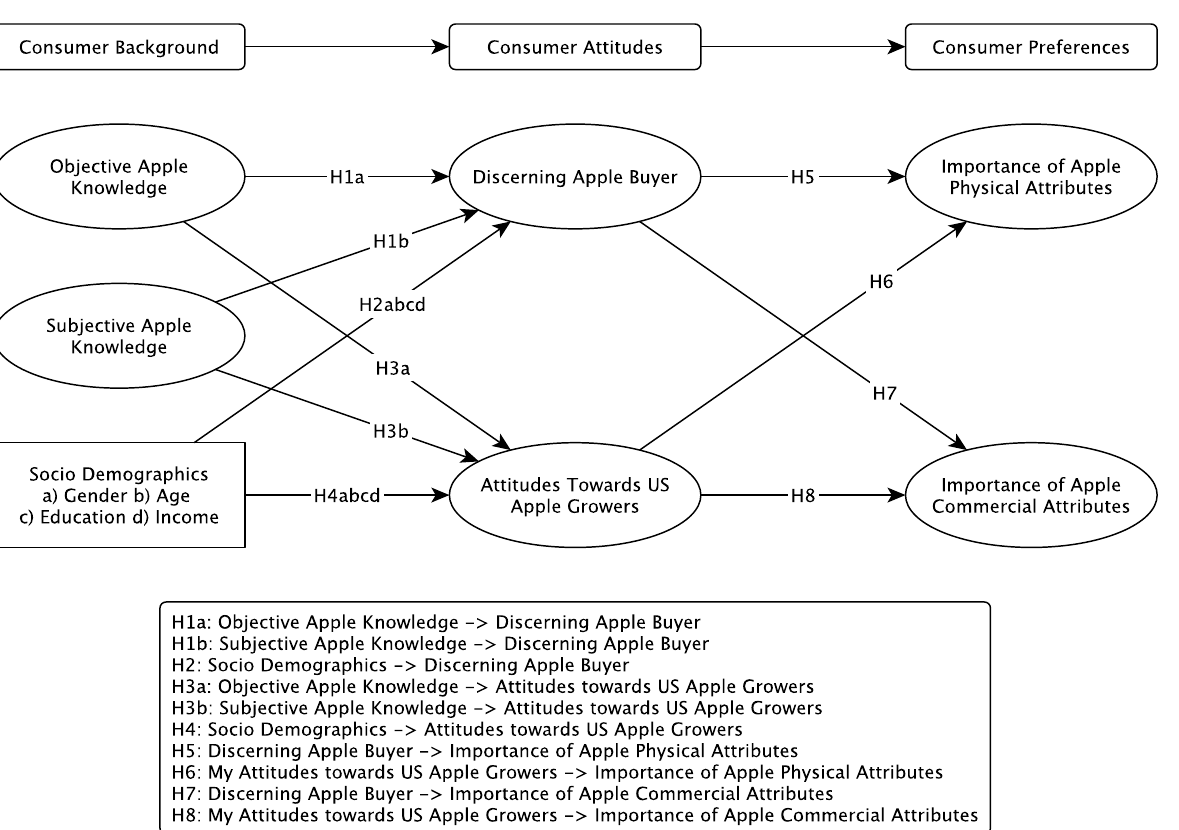
Figure 1. Conceptual Framework.